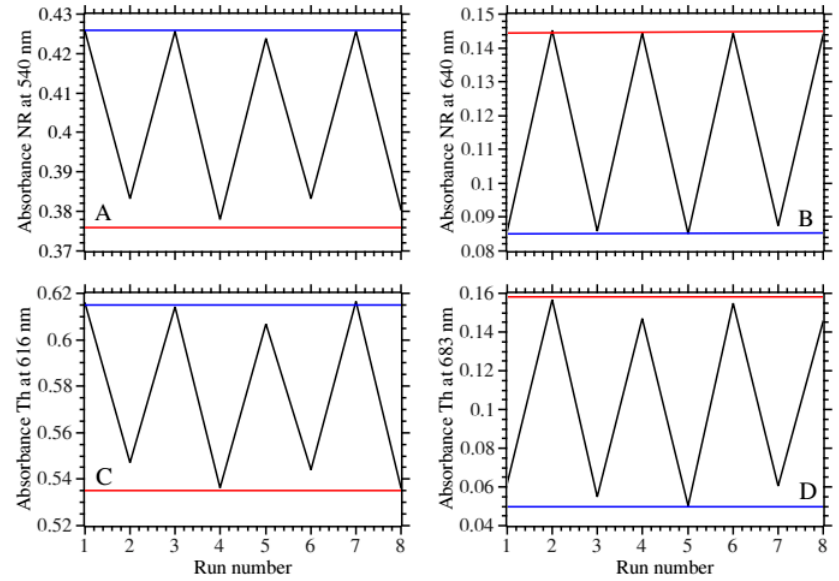
Figure 7. Operational stability: successive monitoring of absorbance and fluorescence in pH 7 and pH 3.5. Panels ( A , B ): neutral red patch; Panels ( C , D ): Thionine patch. In all panels the blue line corresponds to the absorbance pH 7 (every odd run number); the red line corresponds to the absorbance at pH 3.5 (every even run number).